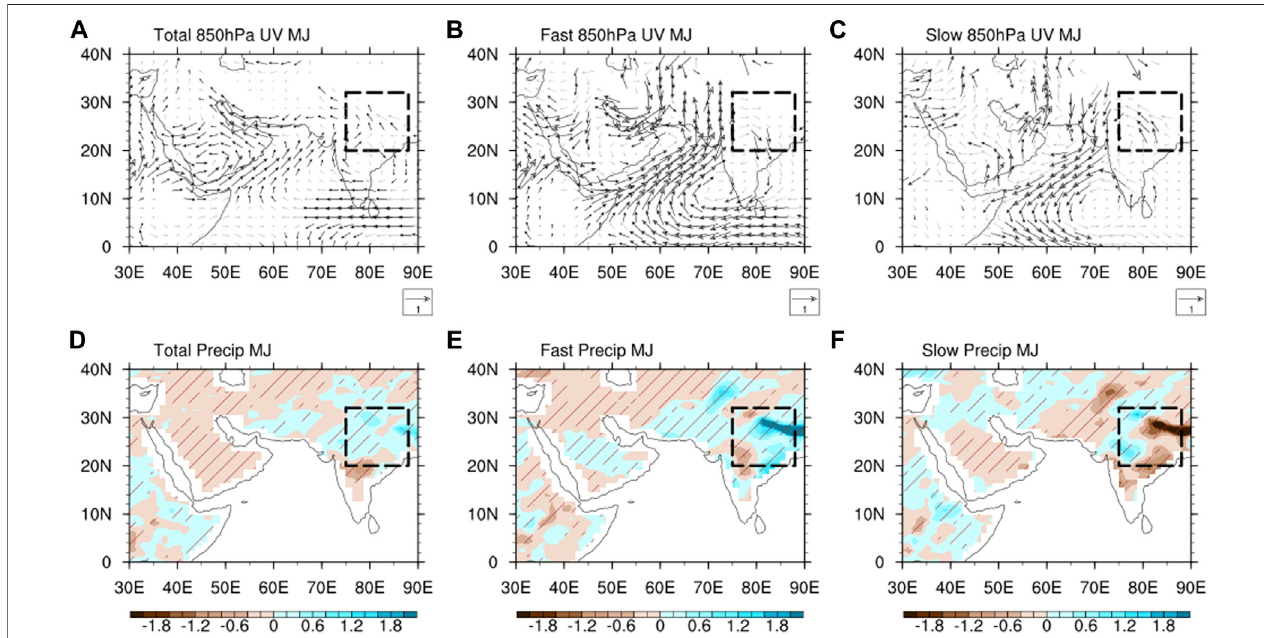
FIGURE 6 | The total [ (A,D) , CMD − CMN], fast [ (B,E) , UMD − UMN] and slow [ (C,F) (CMD − CMN) − (UMD − UMN)] responses of 850 hPa horizontal wind (vectors, A – C , m/s) and precipitation (shaded, D – F, mm/day) to the dust DRE in the early monsoon (May – June). Black (grey) arrows represent the wind vector differences statistically signi fi cant (insigni fi cant) at the 0.1 signi fi cance level. Brown lines represent the precipitation differences statistically signi fi cant at the 0.1 level. Dash boxes indicate the CEI regions same as in Figure 3 .